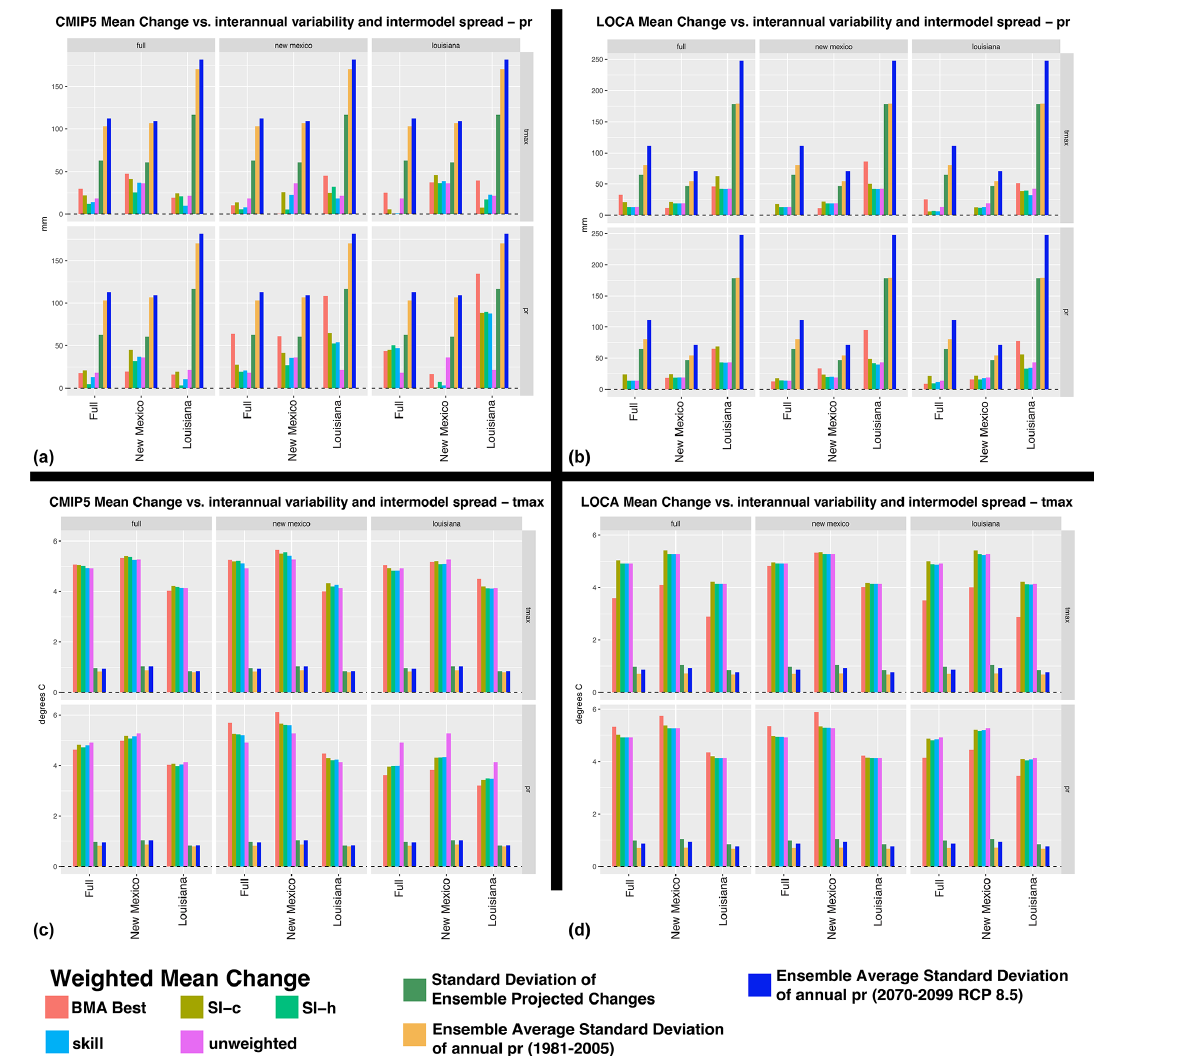
Figure 7. Absolute value of mean projected changes in temperature and precipitation using all 48 weighting schemes, applied to all three domains and both variables (tmax and pr), the standard deviation of the projected changes from the CMIP5 and LOCA ensembles for both variables, and ensemble average standard deviation of annual precipitation and temperature for both the historical and future periods (no weighting is used to calculate any standard deviations). Panels (a, b) focus on pr, the bottom row focuses on tmax, panels (a, c) focus on the CMIP5 ensemble, and panels (b, d) focus on the LOCA ensemble. In an individual group, the top row is the results from weighting schemes derived with tmax, and the bottom row is the results from weighting schemes derived with pr. In addition, within an individual group, the left column shows the results for weighting derived using the full domain, the middle column shows the results for weighting derived using the New Mexico domain, and the right column shows the results for weighting derived using the Louisiana domain. Within a given domain and variable, the results are shown from left to right for the domain the weights are applied